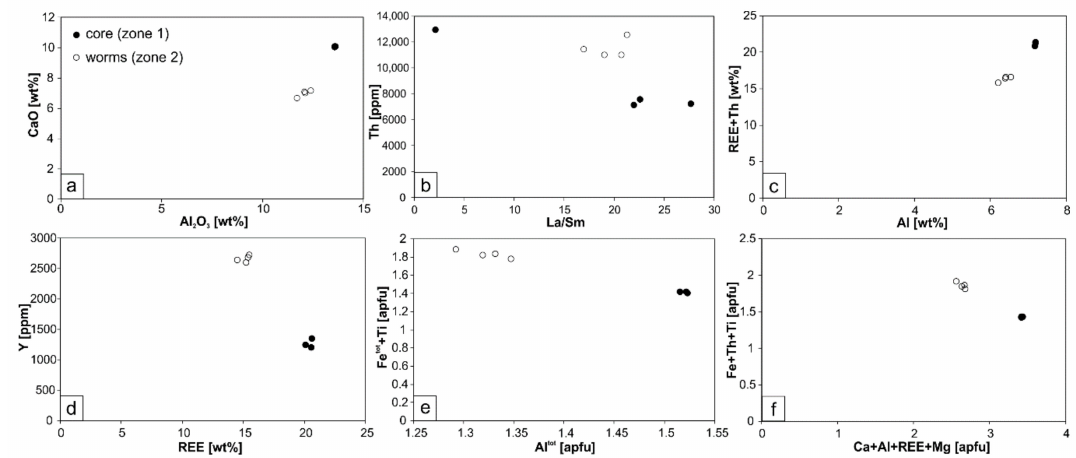
Figure 9. Binary plots showing most prominent compositional di ff erences between the core (zone 1) and the worm-shaped domains of the mantle (zone 2). ( a ) Al 2 O 3 vs. CaO [wt %]; ( b ) La / Sm vs Th [ppm]; ( c ) Al vs. REE + Th [wt %]; ( d ) REE [wt %] vs. Y [ppm]; ( e ) Al tot vs. Fe tot + Ti [apfu]; ( f ) Ca + Al + REE + Mg vs. Fe + Th + Ti